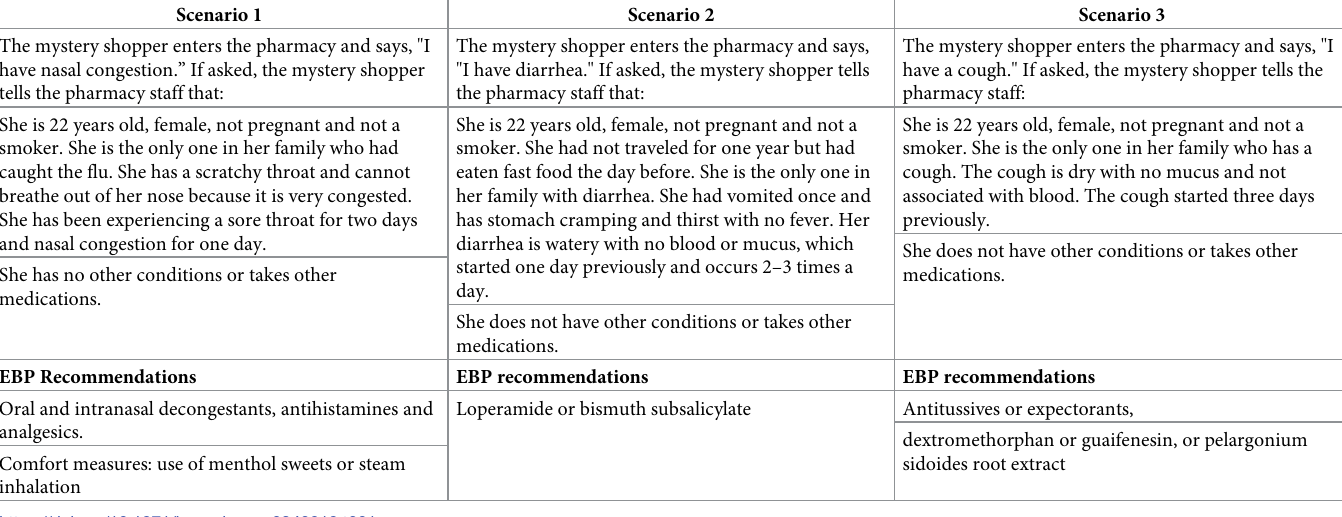
Table 1. Scenarios used in the mystery-shopper